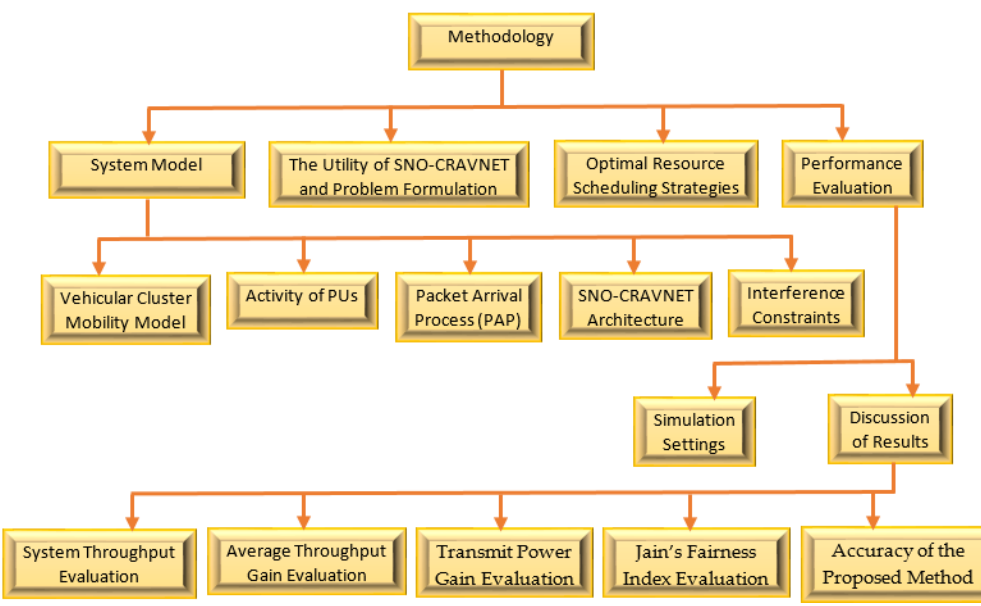
Table 1. List of key mathematical notations.